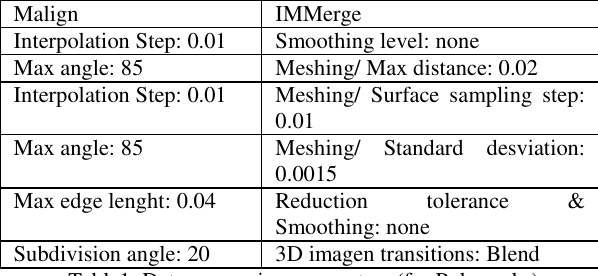
Table1. Data processing parameters (for Polyworks)